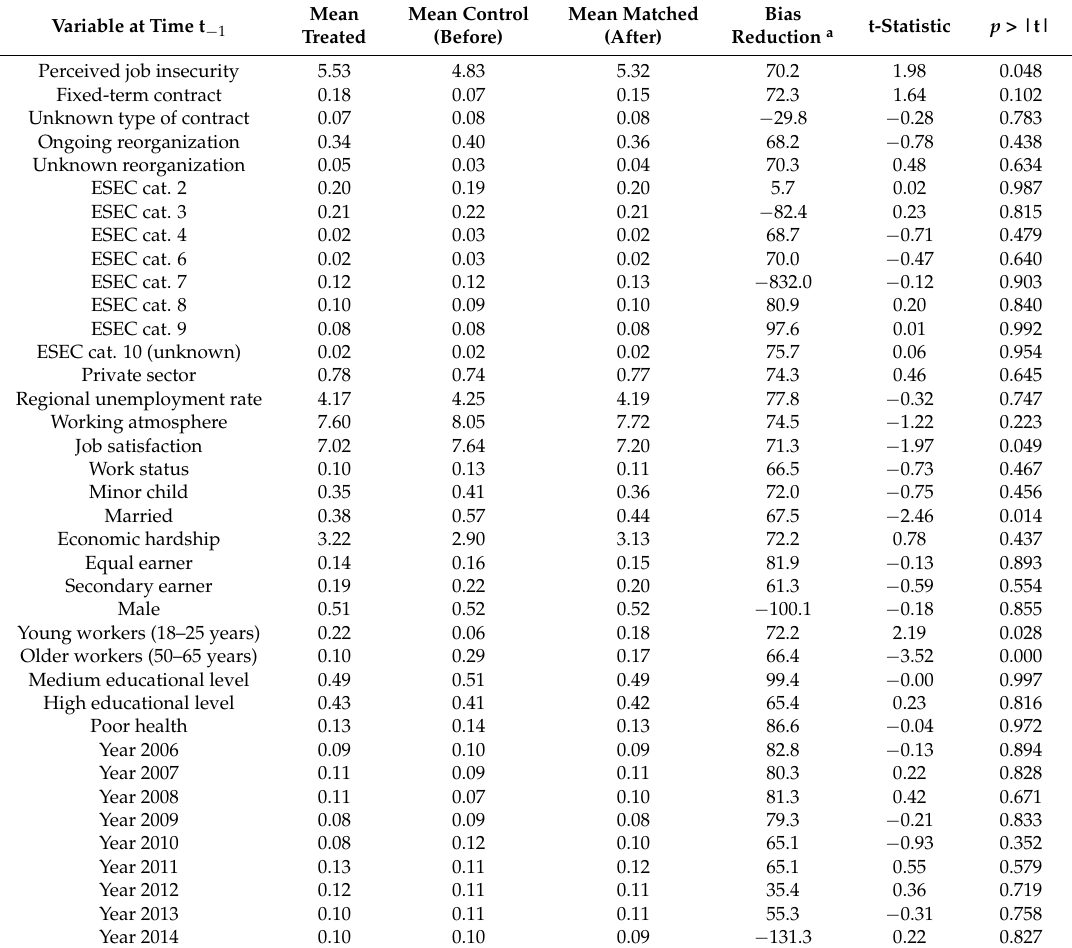
Table A2. Means of predictor variables for voluntary turnover measured before and after matching; bias reduction and